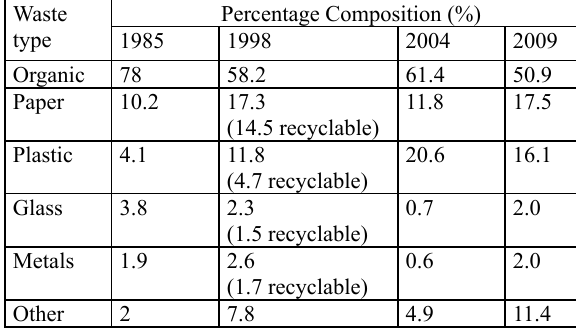
Table 6. Trends in waste composition change in Nairobi. (Year refer to the time of related paper published) (Kasozi & Von Blottnitz,